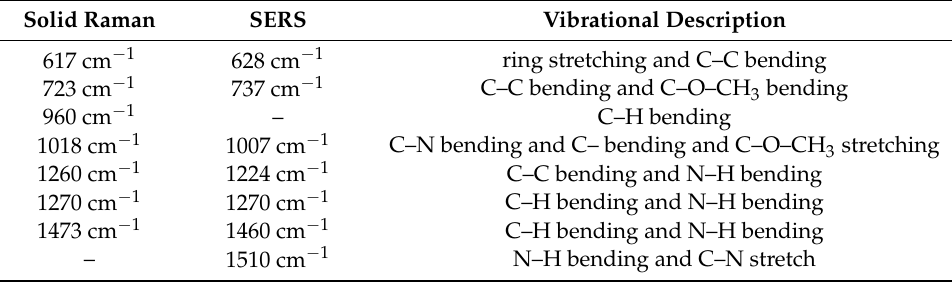
Table 1. Band assignment of carbendazim [17,35].